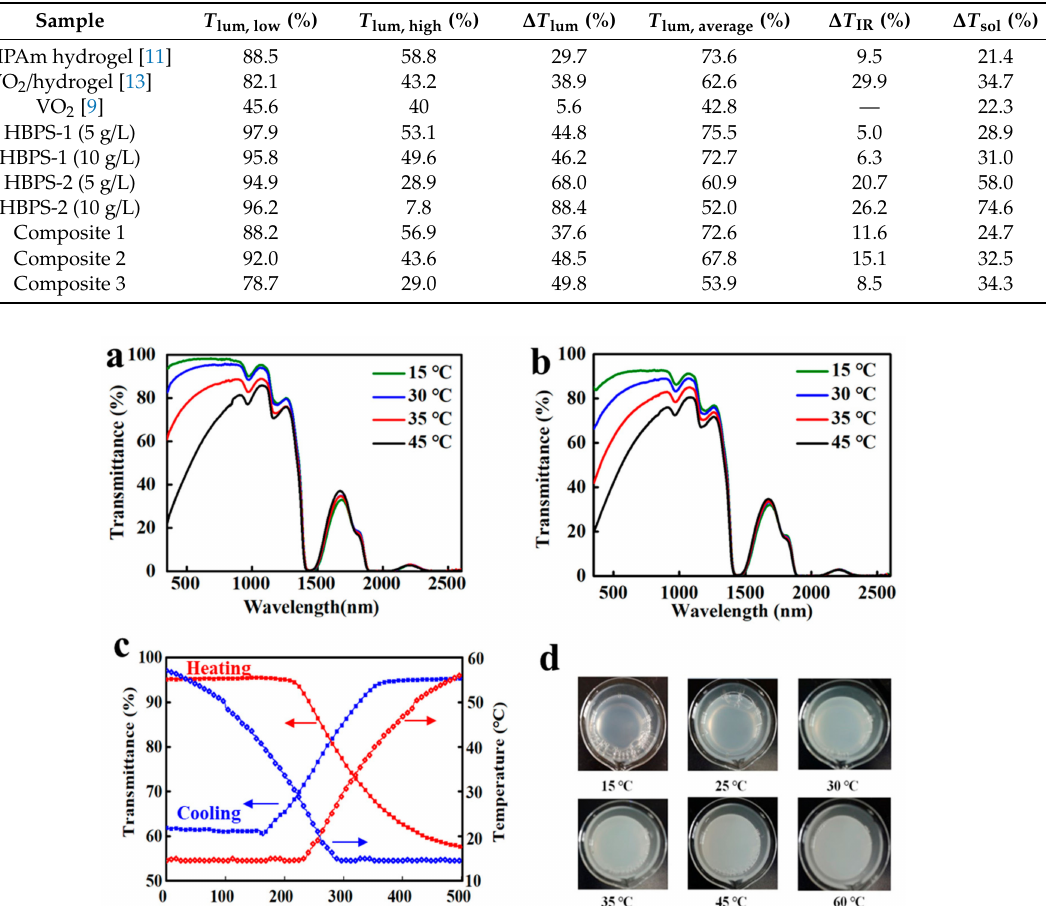
Figure 5. Optical transmittance spectra of ( a ) HBPS-1 (5 g / L) and ( b ) HBPS-1 (10 g / L) at di ff erent temperatures from 15 to 45 ◦ C; ( c ) Temperature and transmittance (at 1100 nm) changes as a function of time through cooling or heating across LCST for HBPS-1 (10 g / L). The heating speed was 0.16 ◦ C / s, and the cooling speed is 0.13 ◦ C / s; ( d ) Pictures of HBPS-1 (10 g / L) at various